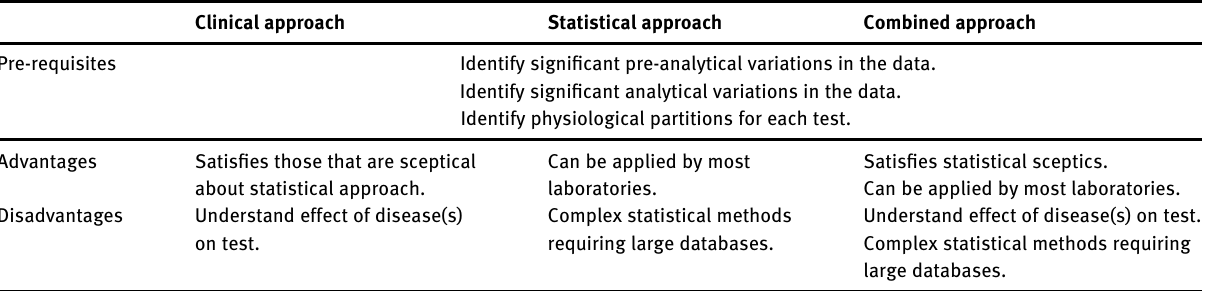
Table  : Comparison of clinical and statistical approaches to separating healthy and diseased populations using indirect reference interval